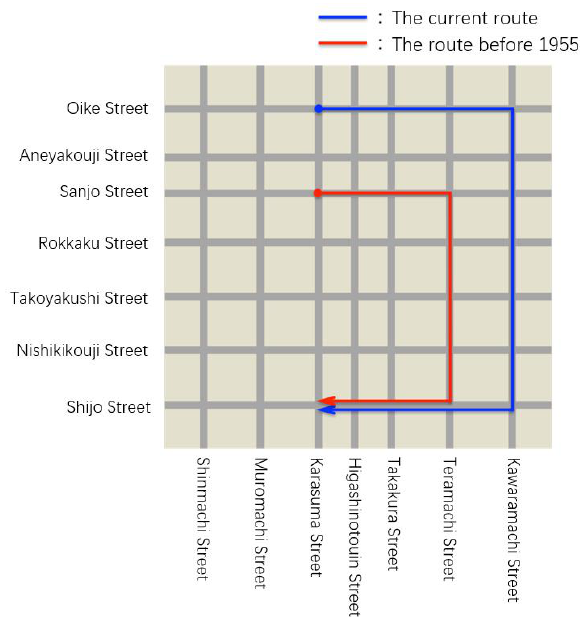
Figure 2. The current route and the original route of the atomatsuri procession of the festival floats in the Gion